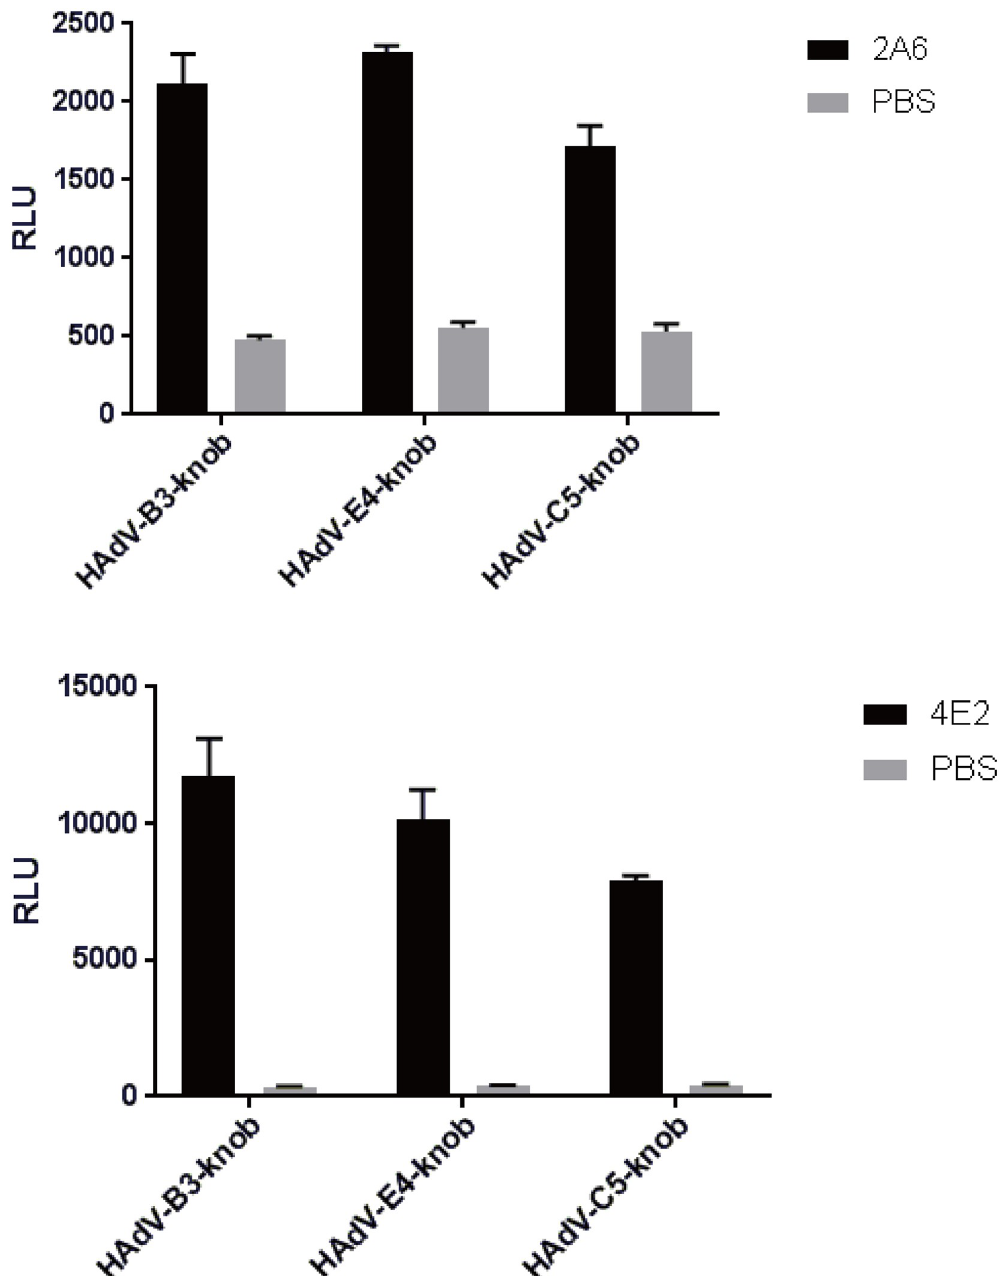
Fig 6. Measurement of knob protein-binding capacity of Fabs 2A6 and 4E2 using CLEIA. The knob protein-binding capacities of Fabs 2A6 and 4E2 were measured by binding to the knob proteins of HAdV-B3, E4, and C5 (negative control). PBS was used as a blank control. The photons of light emitted were measured as RLU. Each knob protein was tested in duplicate, and the result represents the mean ± SD of three measurements.